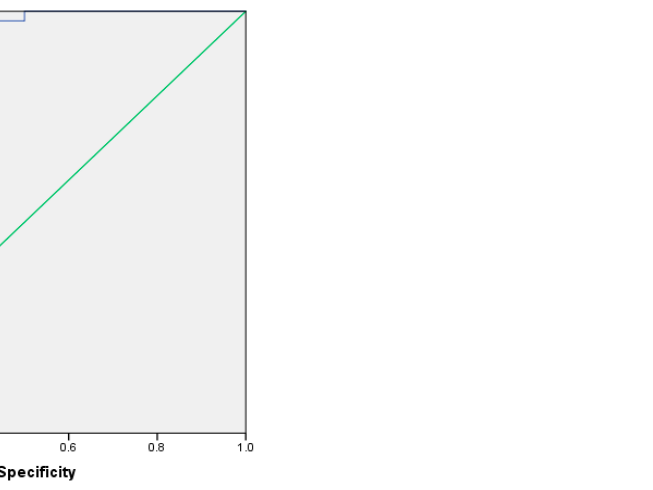
Figure 2. ROC curve for multivariate binary logistic regression. Source: authors’ construction in SPSS 24.